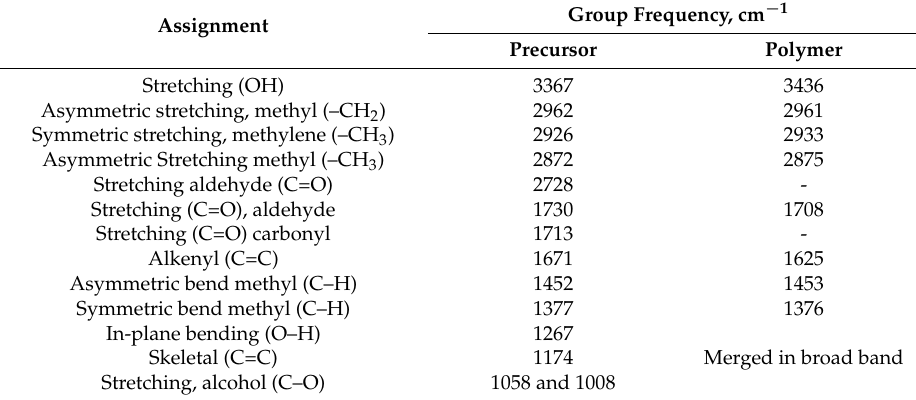
Figure 2. FTIR spectra of geranium essential oil (precursor) and geranium oil-based polymer fabricated at 10 W and 100W. Table 2. FTIR spectra assignments for geranium essential oil and geranium oil-based